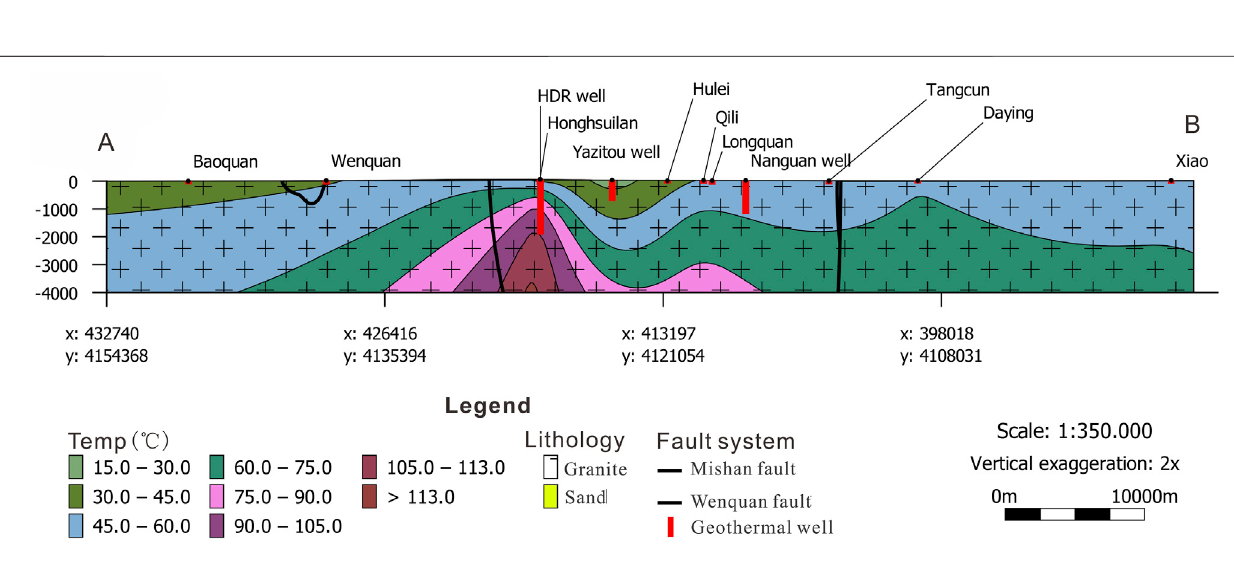
FIGURE 12 | Temperature pro fi le A-B ( Figure 10